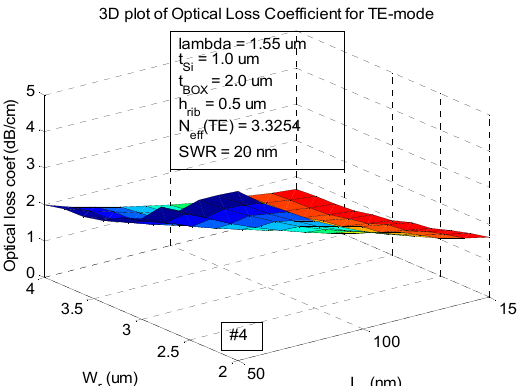
Figure 5. Simulations for the dependences of optical loss of SOI waveguide on both the correlation length and the waveguide width apart from SWR itself of the TE-mode of the waveguide.